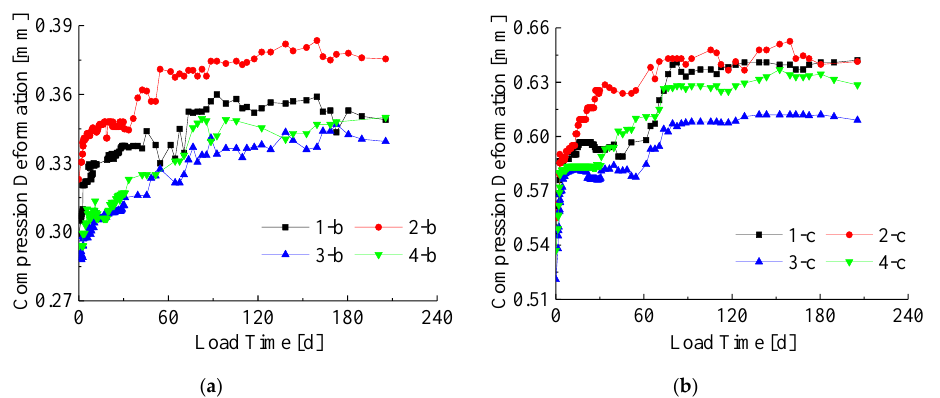
Figure 7. Creep-time curves under the same cross-section condition (with initial displacement): ( a ) Section size of 110 mm × 110 mm; ( b ) Section size of 130 mm × 130 mm.